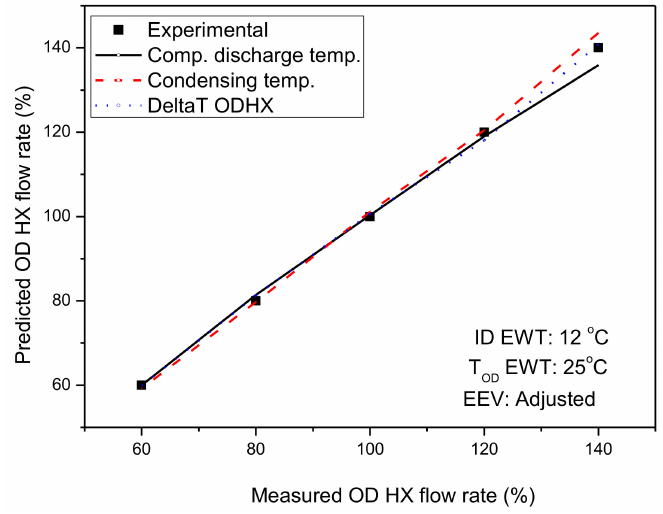
Figure 12. Comparison between predicted and measured condenser SFFR at standard T OD